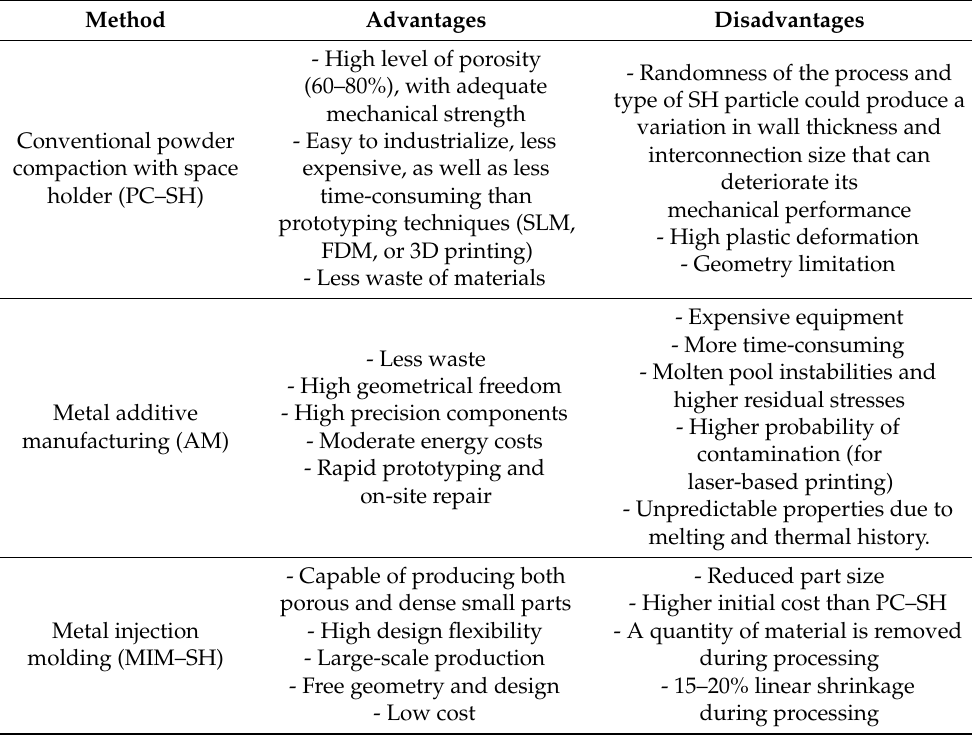
Table 1. Comparison of the different techniques for processing highly porous Ti